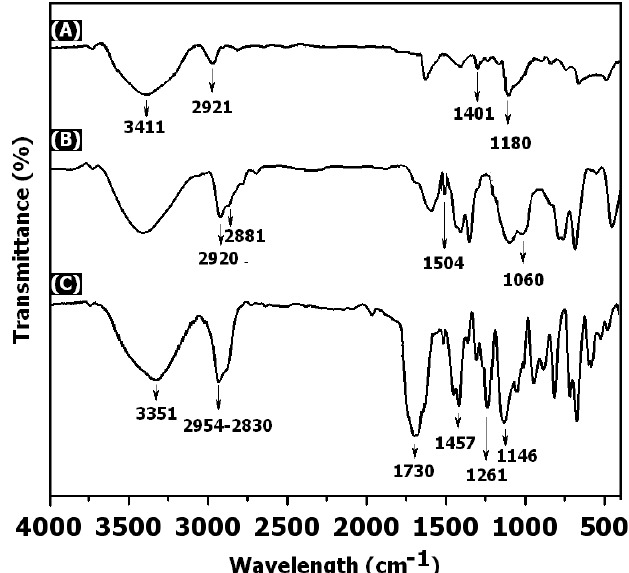
Figure 1. Fourier transform infrared (FT-IR) spectra of ( A ) CdTe-OH, ( B ) CdTe- S-benzyl S’-trimethoxysilylpropyltrithiocarbonate (BTPT), and ( C ) PPEGMA-grafted CdTe (PPEGMA-g-CdTe).